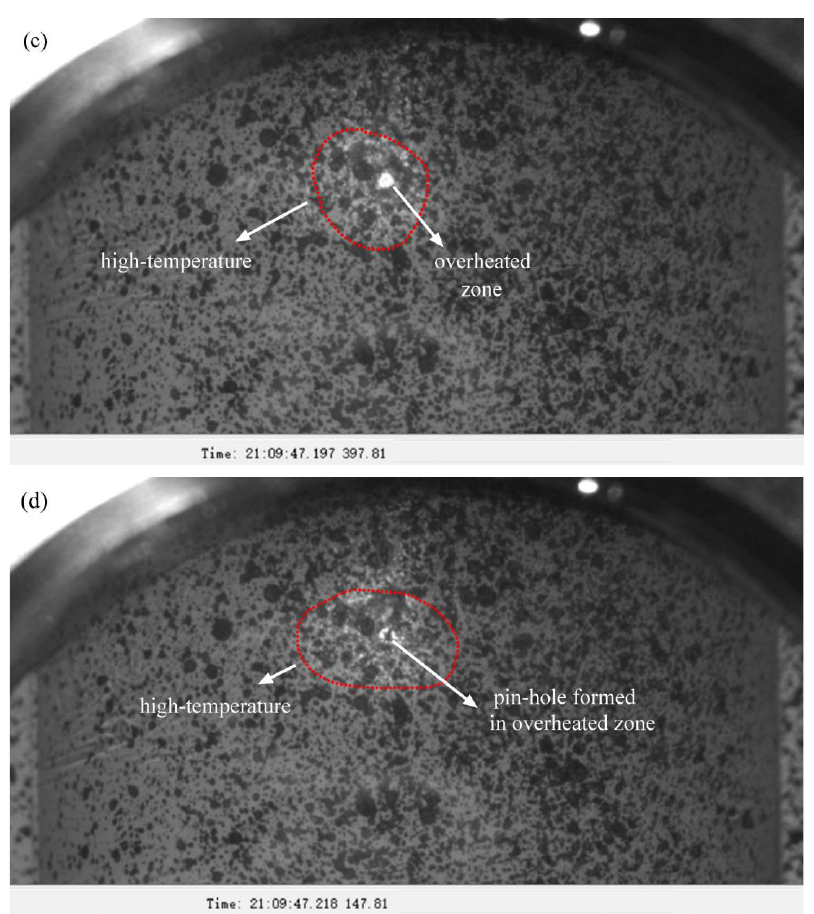
Figure 8. Dynamic evolution behavior during the burn-through process of the 26O-1: ( a ) 0.994 s; ( b ) 1.126 s; ( c ) 1.197 s; ( d ) 1.218 s.